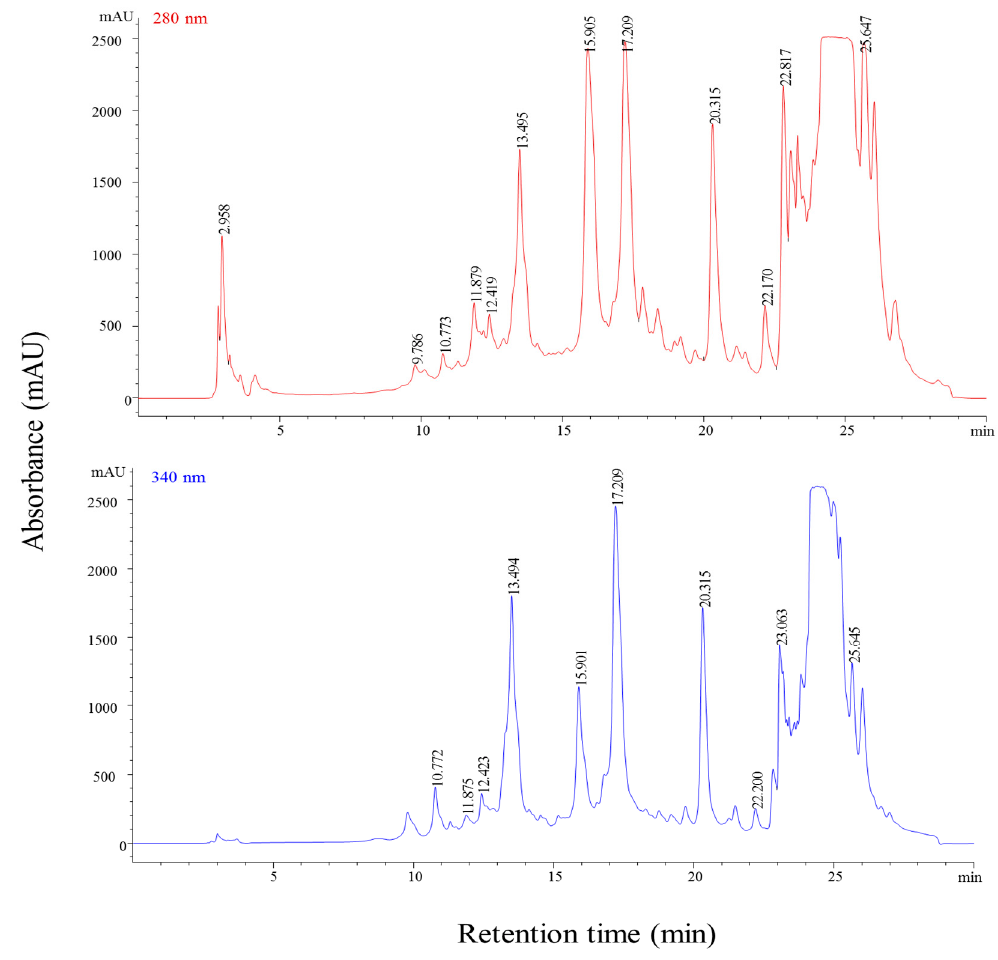
Figure 1. LC chromatogram of Pg extract (20 mg at 280 and 340 nm). Table 3. Phenolic compounds in poplar bud samples obtained by LC-MS analysis. Peak